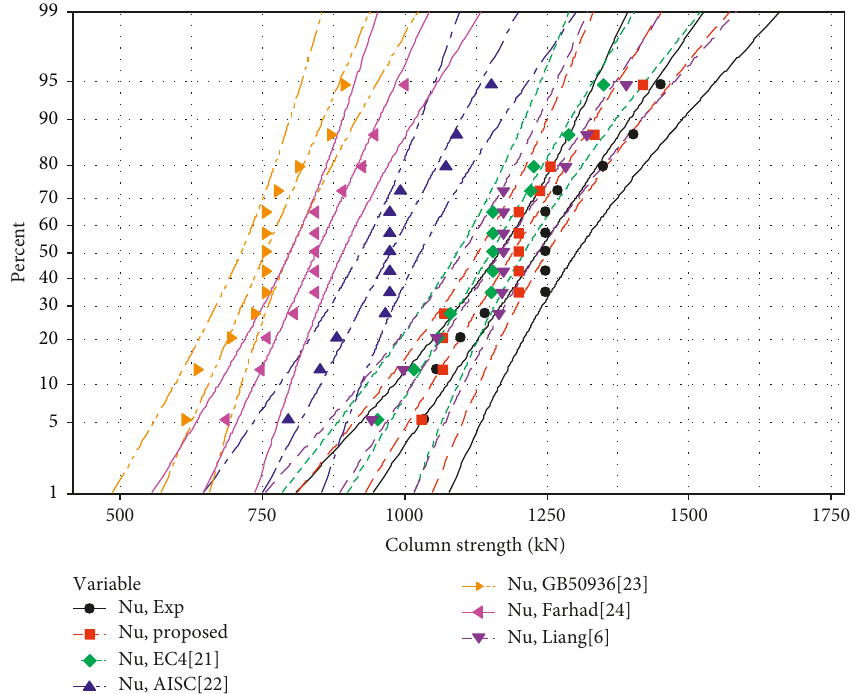
Figure 8: Validation of test results with various International codes and model proposed in [6, 23]: comparison.